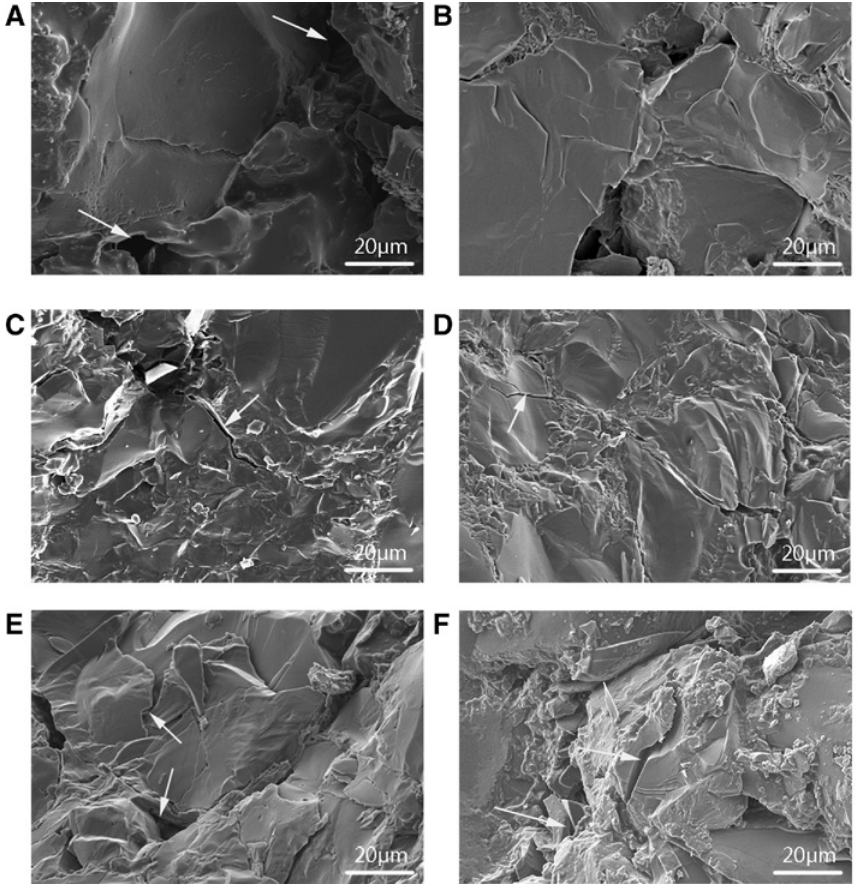
Figure 7: SEM micrographs showing creep damage mechanisms: (A) stress of 0.00 MPa; (B) stress of 4.00 MPa; (C) stress of 4.50 MPa; (D) stress of 5.00 MPa; (E) stress of 5.25 MPa; (F) stress of 5.50